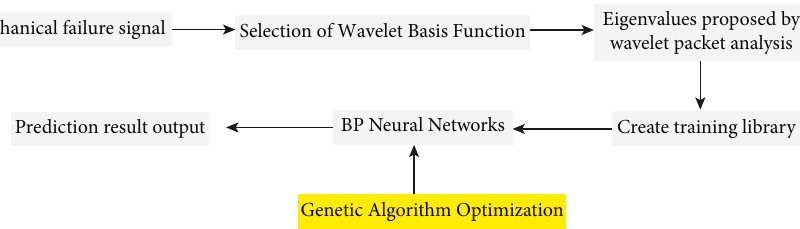
Figure 6: Mechanical malfunction identification system based on GA optimized neural network.